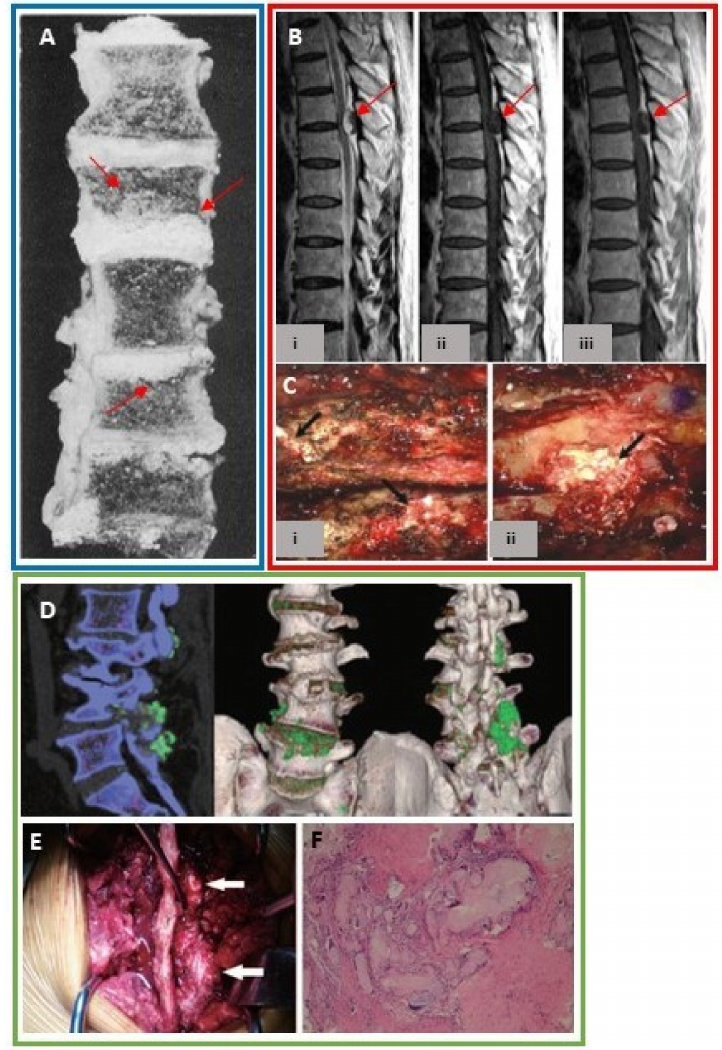
Figure 3. ( A ) Cross section of the spine from necropsy demonstrates urate deposits within the intervertebral discs with extension into the adjacent vertebral bodies (red arrows). With permission from an article published in Am. J. Pathol. 1956;32(5):871–895, Lichtenstein L., et al., Pathologic changes in gout; survey of eleven necropsied cases, copyright Elsevier 1956 [27]. ( B ) Sagittal (i) T2-weighted (ii) T1-weighted (iii) T1-weighted post gadolinium MRI of the thoracic spine shows an epidural mass (red arrows) compressing the spinal cord [48]. ( C ) Intra-operative findings on the same patient reveal a chalky whitish mass within the (i) epidural space under the ligamentum flavum extending into the T5-T6 neural foramina and (ii) T5-T6 and T6-T7 interlaminar space. Histopathology reveal urate crystals. With permission from Yoon J-W, et al, Tophaceous Gout of the Spine Causing Neural Compression. Korean J. Spine 2013;10(3):185–188 distributed in accordance with CC BY-NC 3.0, http: // creativecommons. org / licenses / by-nc / 3.0 / [48]. ( D ) Sagittal and 3-dimensional reconstruction DECT images of the lumbar spine display urate deposits (green) within L1-L5 intervertebral discs. Tophi are also seen within the L2-L3 and L4-L5 facet joints [51]. ( E ) Intra-operative findings in the same patient demonstrate chalky white material at L2-L3 and L4-L5 facet joints corresponding to the DECT images. ( F ) Histopathology confirms urate crystals. With permission from Lu H, et al. Tophaceous gout causing lumbar stenosis: A case report. Medicine (Baltimore) 2017;96(32):e7670. https: // journals.lww.com / md-journal / Fulltext / 2017 / 08110 / Tophaceous_gout_causing_lumbar_stenosis__A_case.22.aspx , [51]. The Creative Commons license does not apply to this content. Use of the material in any format is prohibited without written permission from the publisher, Wolters Kluwer Health, Inc. Please contact permissions@lww.com for information. Images from a single patient are outlined in a